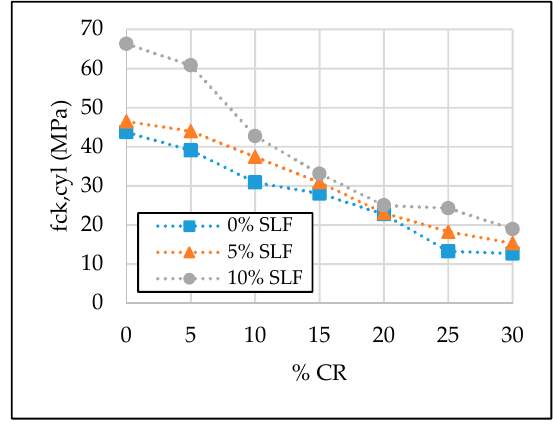
Materials 2020 , 13 , x FOR PEER REVIEW Figure 12. The e ff ect of crumb rubber and silica fume on 28-day compressive strength. Figure 12. The effect of crumb rubber and silica fume on 28-day compressive strength. Figure 12. The effect of crumb rubber and silica fume on 28-day compressive strength.